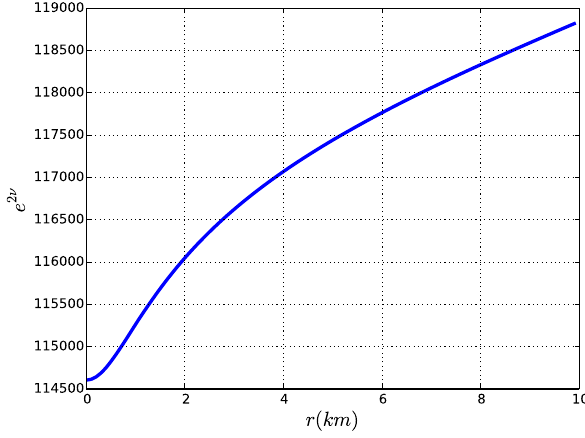
Fig. 4 Proper charge density σ 2 against radial distance r